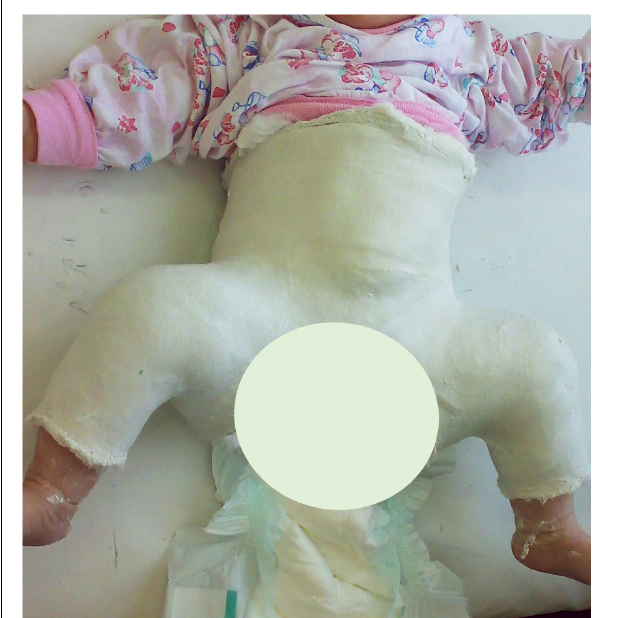
FIGURE 1 | A 4.5-months-old baby-girl with left hip dislocation after closed reduction and spica